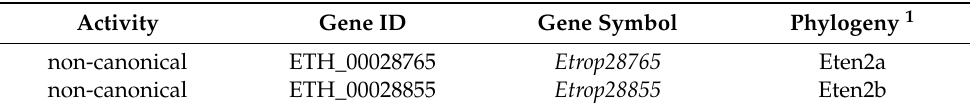
Table 1. Cont. Activity Gene ID Gene Symbol